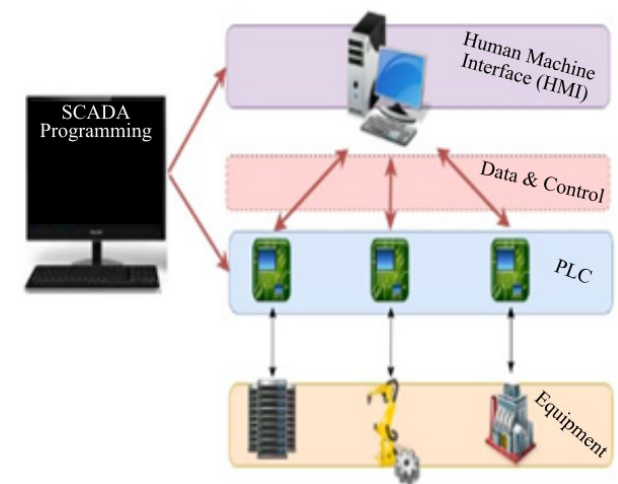
Fig. 3. SCADA System and components